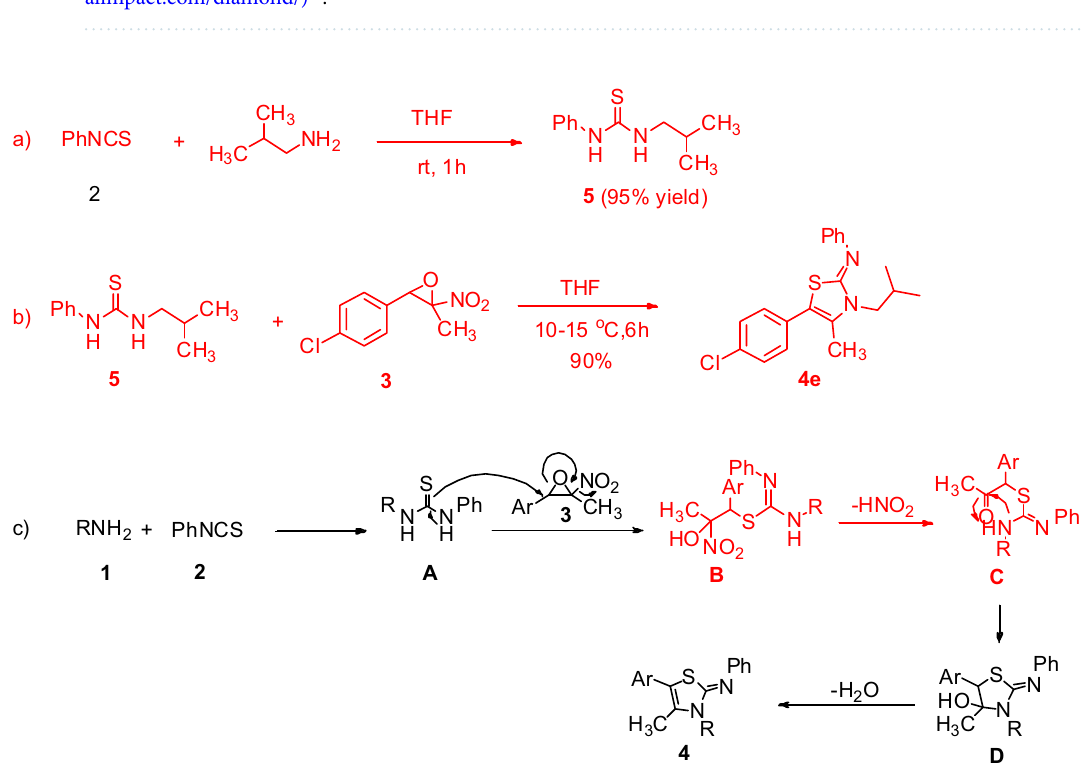
Figure 2. ORTEP representation of the structure 4p . The figure was drawn by DIAMOND (https:// www. cryst alimp act. com/ diamo nd/) 53